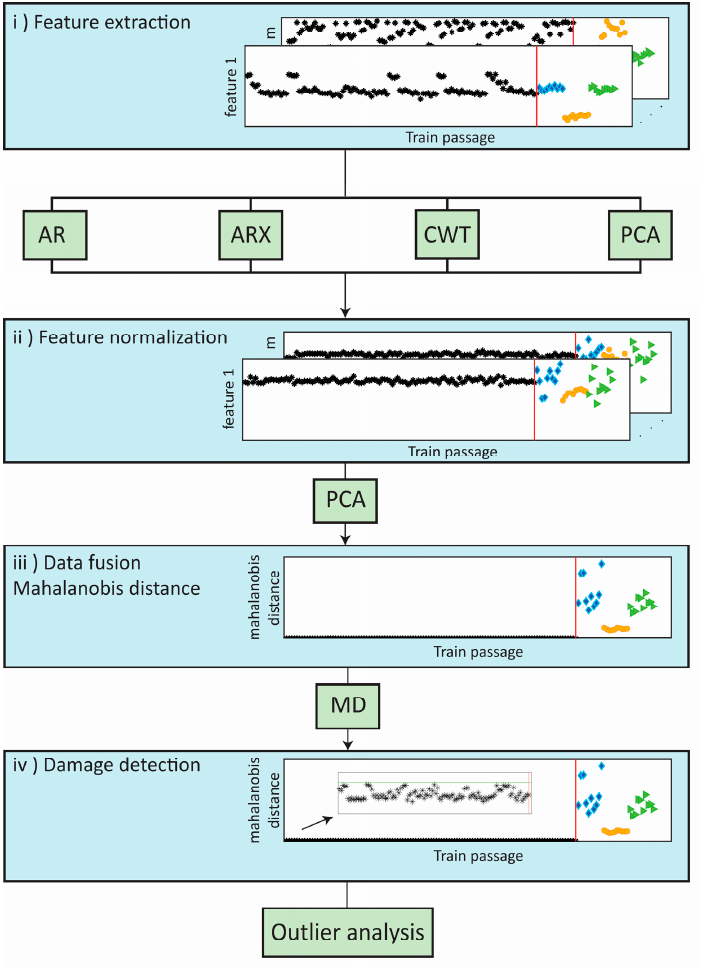
Figure 6. Methodology of the automatic detection of wheel flats.